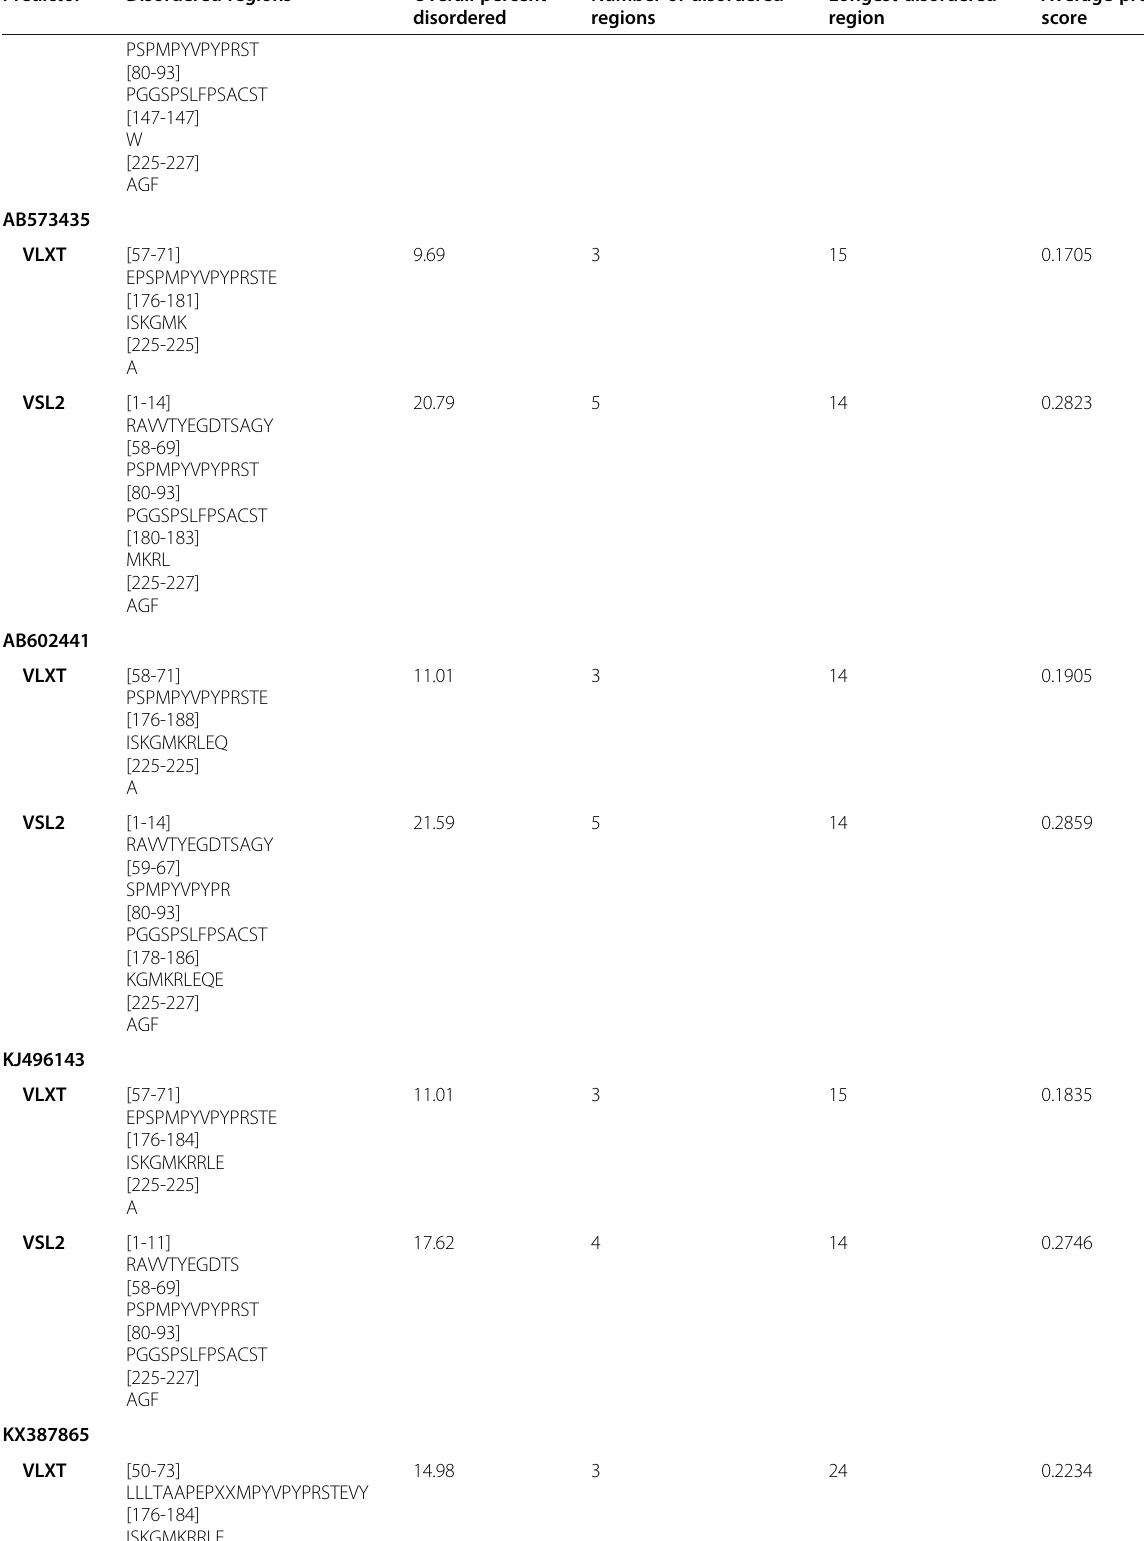
Table 2 The predicted percentage of intrinsic disorder scores of YDR in hepatitis E viruses (Continued)